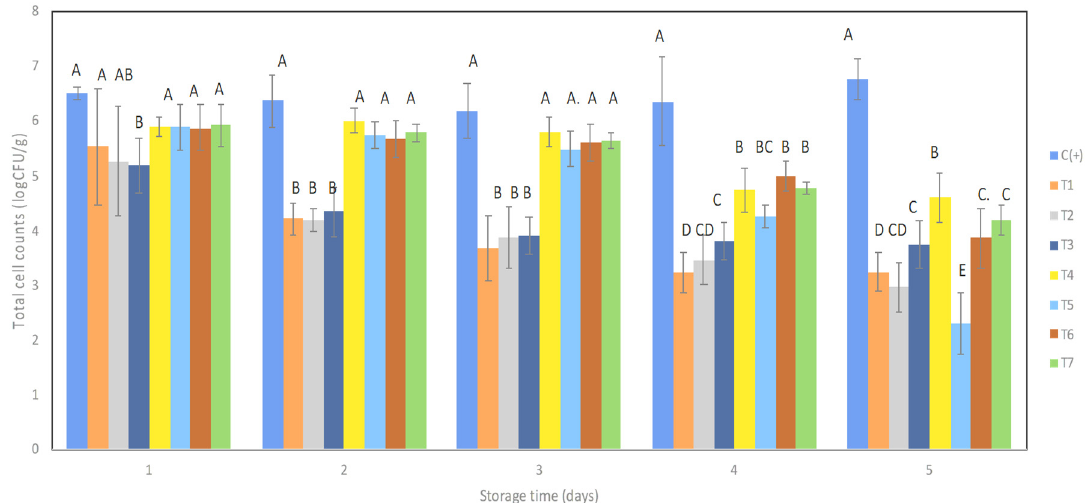
Figure 2. Changes in the total cell counts of the target FSBM detected in mango wedges treated with the antimicrobial cocktails during storage. The results are expressed in log (CFU/g). Legend: Control (+): mango wedges + FSBM; T1: (Cys5-4+ Gt28) CFS: 1:1 ( v/v ); T2: (Cys5-4+ Gt28) CFS: 1:3 ( v/v ); T3: (Cys5-4+ Gt28) CFS: 3:1 ( v/v ); T4: (Cys5-4+ Gt28) PP: 1:1 ( v/v ); T5: (Cys5-4+ Gt28) PP: 1:3 ( v/v ); T6: (Cys5-4+ Gt28) PP: 3:1 ( v/v ); T7: Nisin (50 µ g/mL); FSBM-five-strain bacterial mixture; CFS-cell free supernatant; PP: partial precipitated peptides. The bars represent the mean ± SD of three independent repetition. The capital letters represent the significant decrease ( p < 0.05) in cell counts vs control (+) at different time points (days). Table 4. Antibacterial cocktails activity against Shigella/Salmonella / E. coli at day 5 with storage at 4 °C determined in mango wedges. Percentages of reductions were calculated relative to control (+).